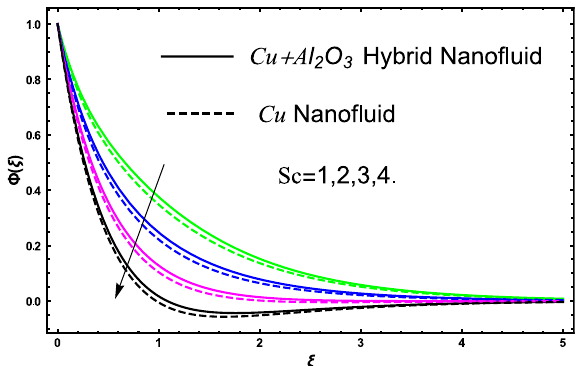
Figure 10. The fluctuation of concertation φ(ξ) versus greater values of Sc .